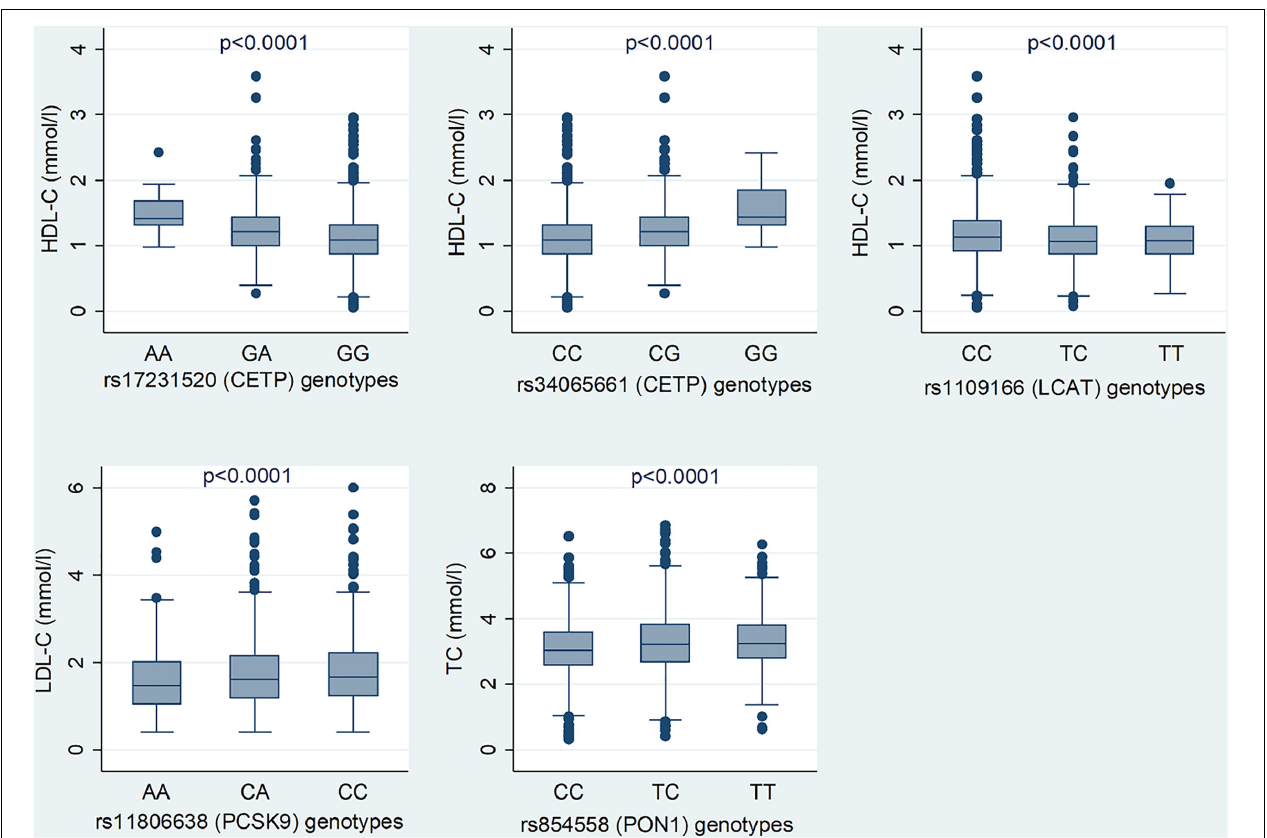
FIGURE 2 | Median lipid levels for the genotypes of the lead SNVs among Ghanaian adults. The p value is adjusted for age, sex and waist